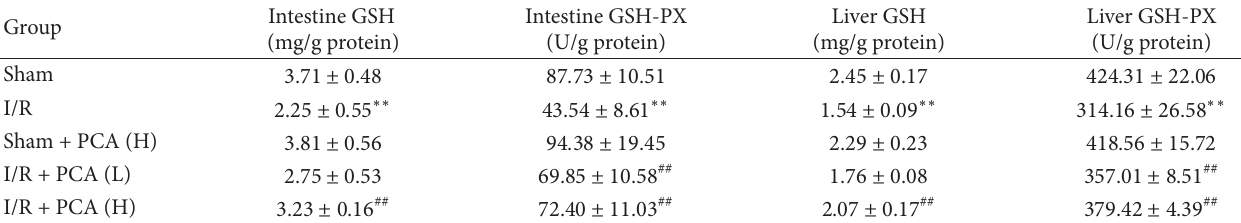
Table 1: PCA pretreatment ameliorated intestinal I/R induced GSH system dysfunction in the intestine and liver.